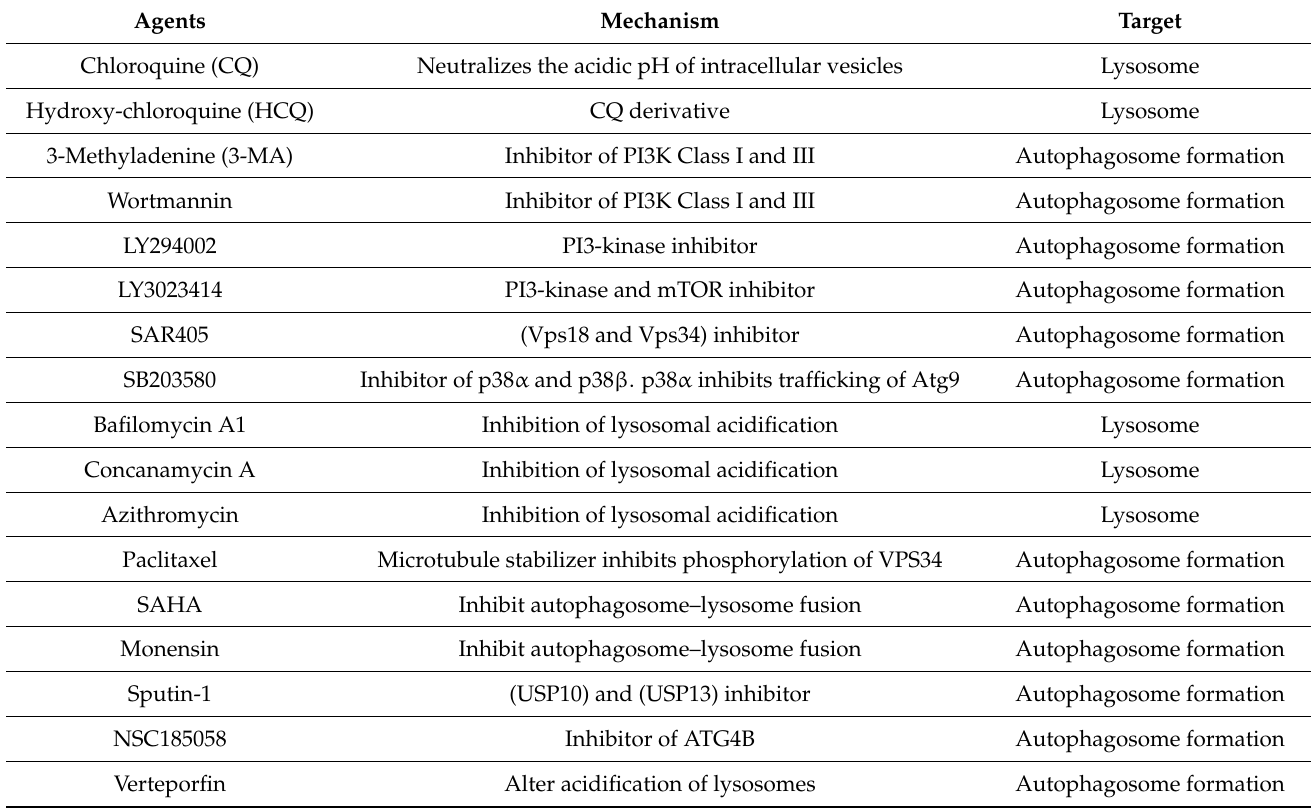
Table 2. Small agents and drugs that effectively inhibit autophagy. In the table, many small molecules and drugs that are already used to inhibit autophagy are shown. Moreover, the main mechanism of action and the target point in the autophagy procedure where they act is